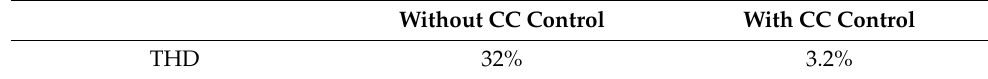
Table 3. Comparison in terms of control strategy.